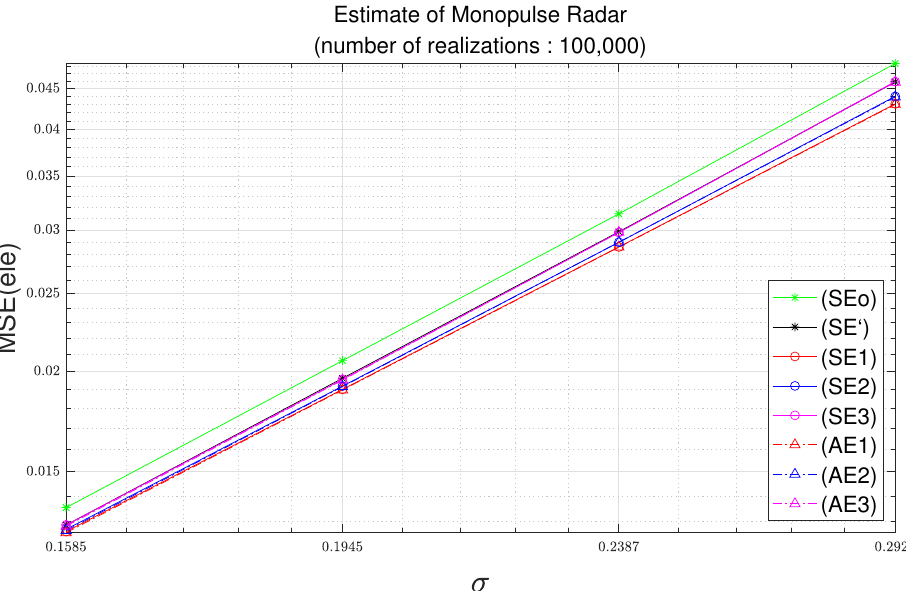
Figure 4. Elevation MSE as function of standard deviation with parameters of Table 2 and 100,000